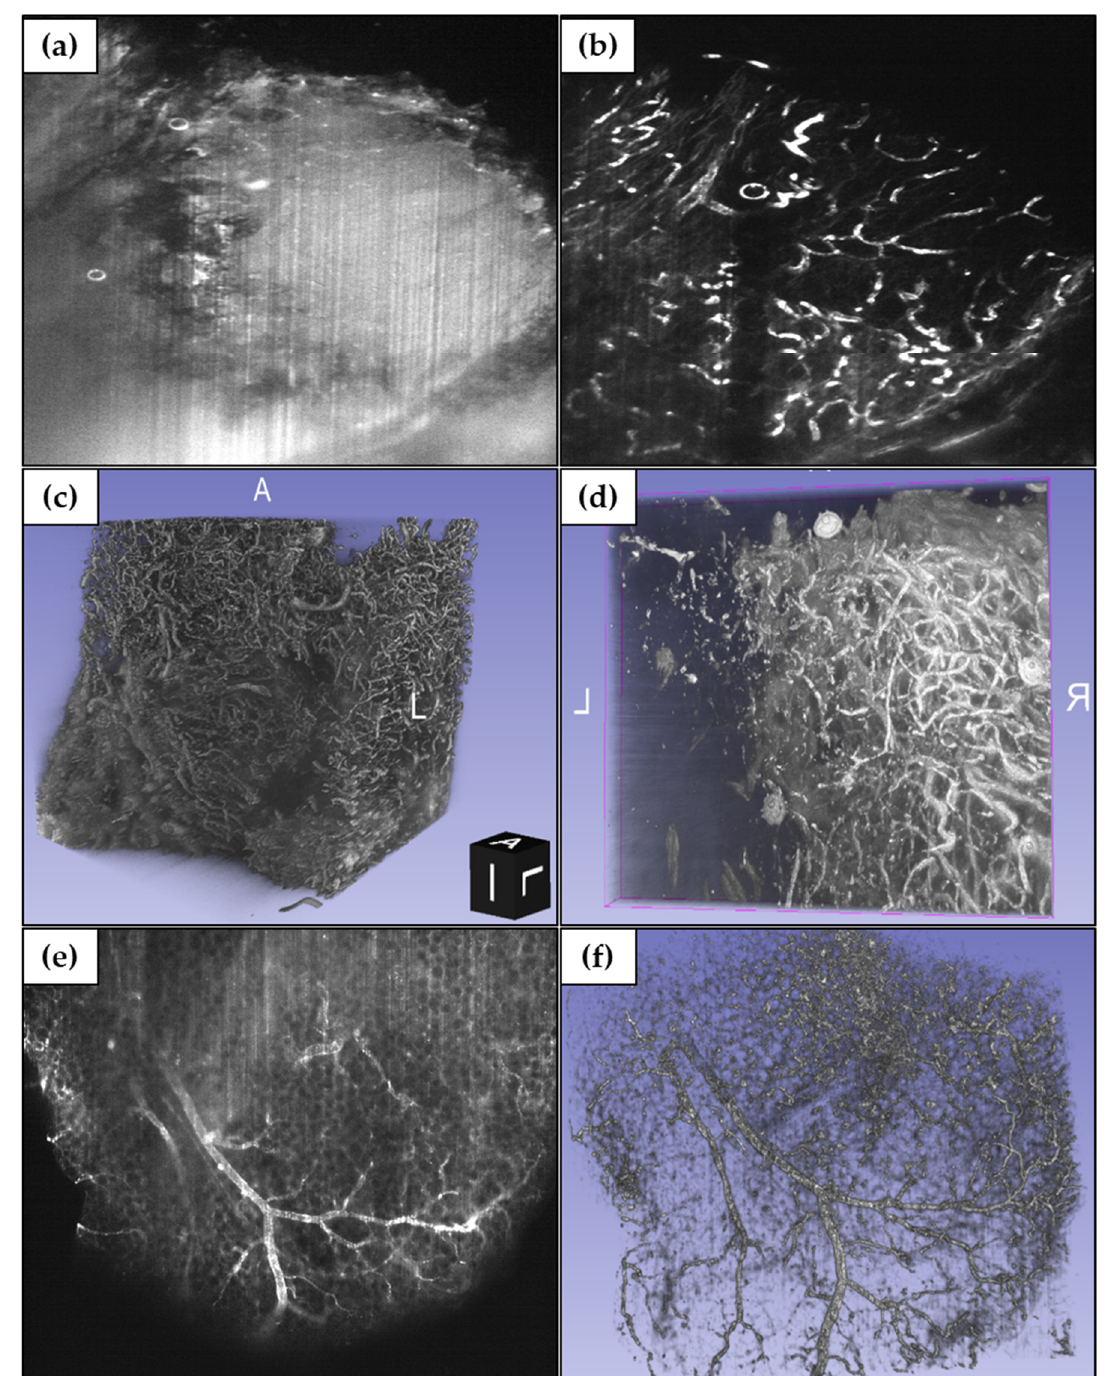
Figure 11. ( a , b ) SPIM images of ( a ) DAPI staining and ( b ) Factor VIII staining, 5 × magnification. ( c , d ) Three-dimensional reconstructions of vasculature structure from acquired SPIM images, ( c ) 5 × , and ( d ) 10 × magnification. ( e ) SPIM images of cleared xenograft melanoma model, Factor VIII stain- ing, 5 × magnification. ( f ) Three-dimensional reconstruction of cleared xenograft melanoma model sample vasculature structure from acquired SPIM images, 5 × magnification. The window/level was adjusted uniformly on all images for better